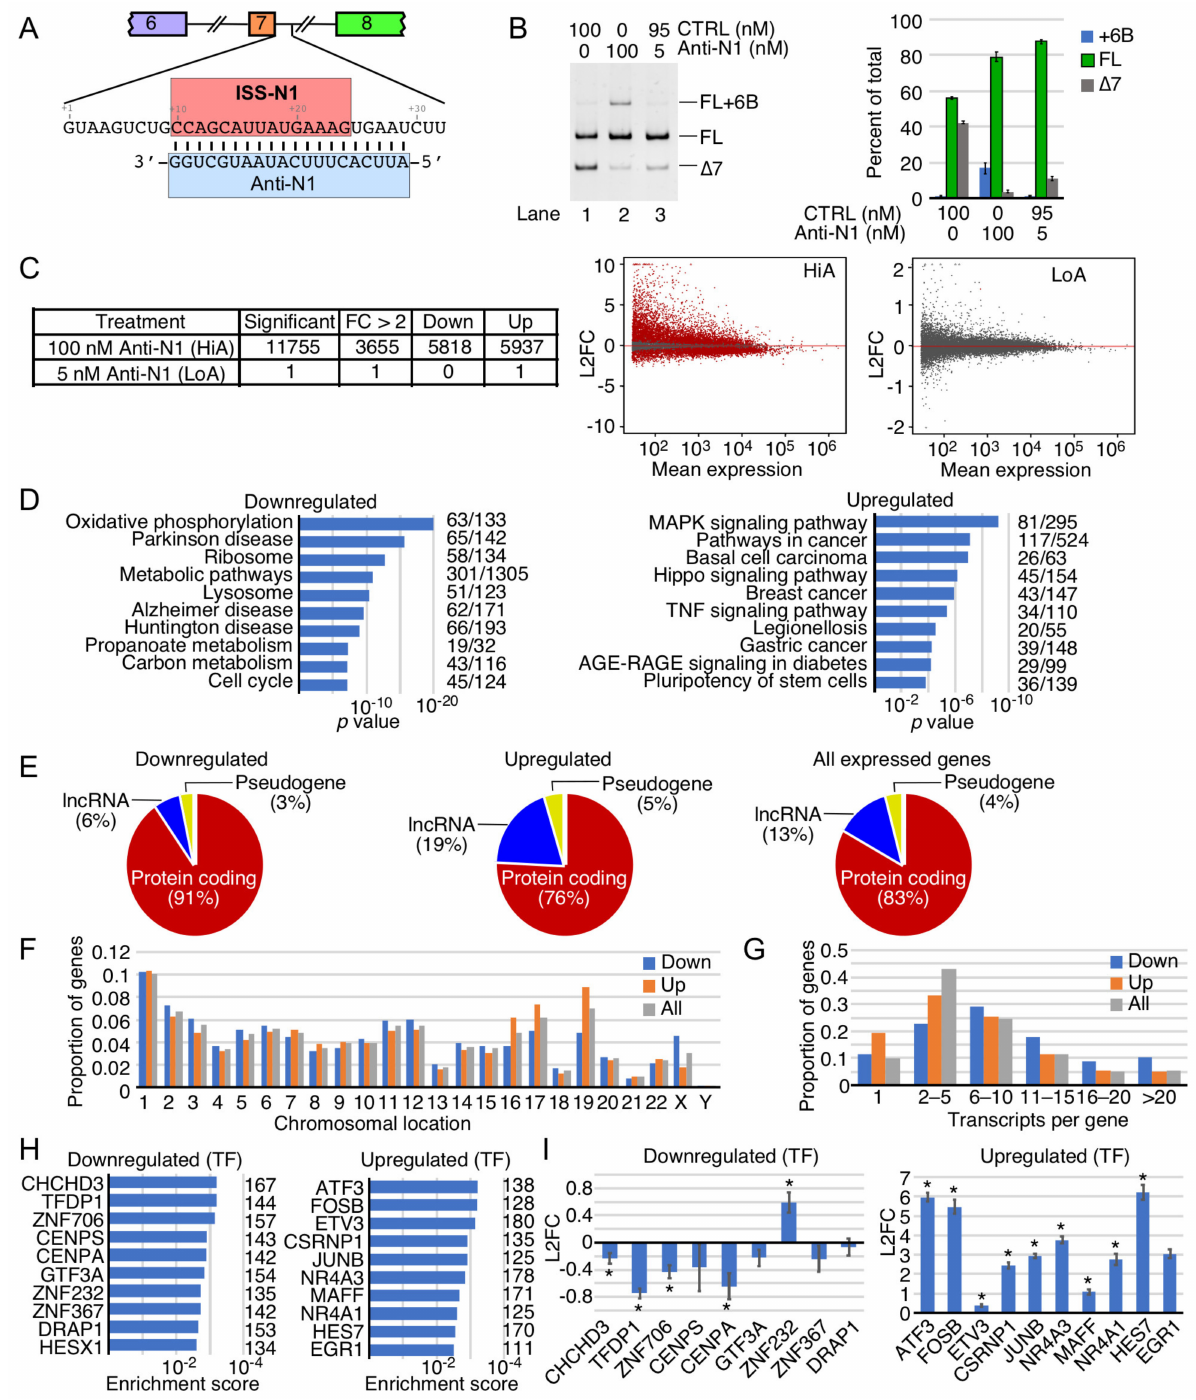
Figure 1. Gene expression after treatment with Anti-N1 ASO. ( A ). Schematic of Anti-N1 and its intronic target sequence ISS-N1. Exons are depicted as colored-numbered boxes, and introns are depicted as broken lines. The sequence immediately downstream of exon 7 is depicted below. Nucleotide numbering starts from the first position of intron 7. ISS-N1 is boxed in red and Anti-N1 ASO is marked with a blue box. Black lines show base pairing between Anti-N1 and its target sequence. ( B ). Alternative splicing of SMN2 exon 7 after treatment with the indicated concentrations of Anti-N1. Left panel: representative ethidium bromide-stained gel depicting semiquantitative RT-PCR of SMN2 (from exon 6 to exon 8). ASO concentrations are provided at the top of the gel. Splice isoform identity is provided at the right side of the gel. Right panel: densitometric quantification of RT-PCR results. Error bars represent the standard error of the mean. n = 3. Abbreviations: CTRL, control ASO; FL, canonical full-length isoform. ( C ). Overview of differential expression analysis of RNA-Seq performed on Anti-N1-treated GM03813 SMA patient fibroblasts. Left panel: Overall summary table